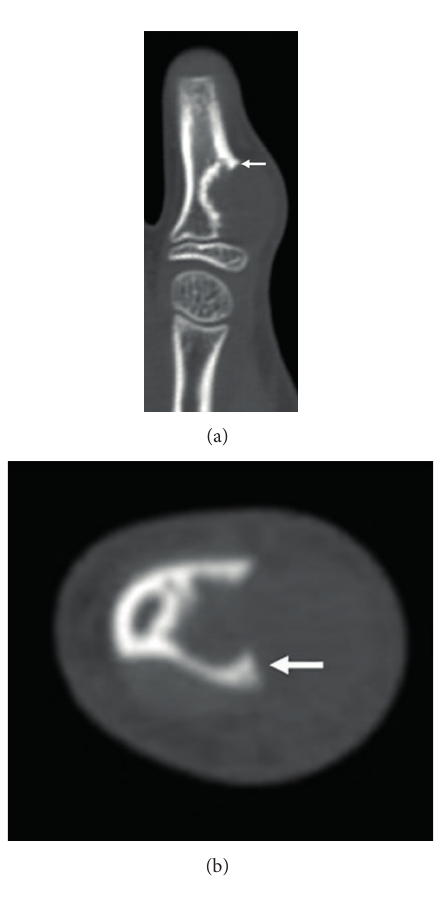
Figure 3: Coronal (a) and axial (b) computed tomography scans show cortical overhanging margins at the periphery of the lesion